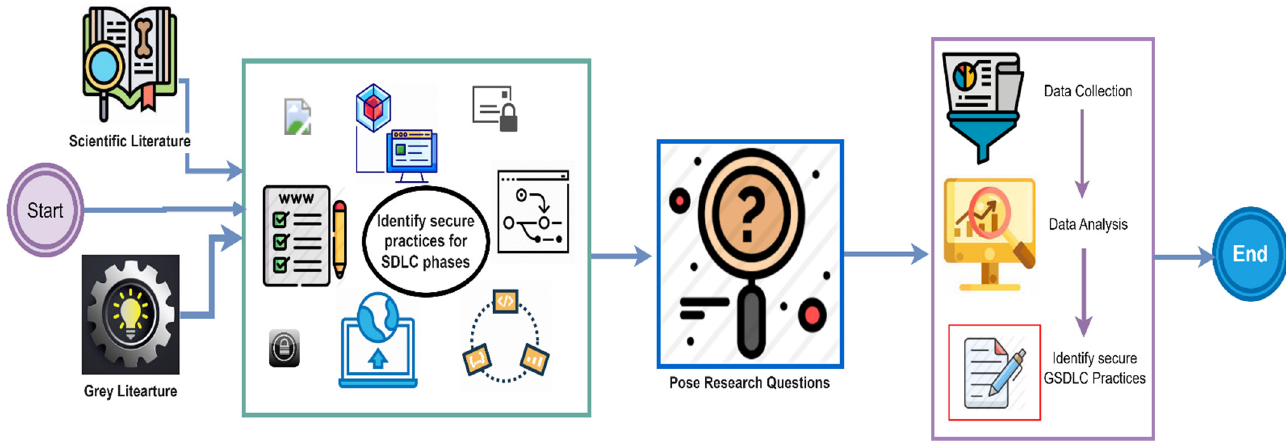
Figure 2 . Research methodology process . Figure 2. Research methodology